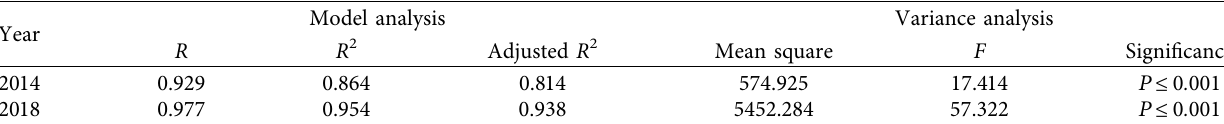
Table 3: Model analysis and analysis of variance.